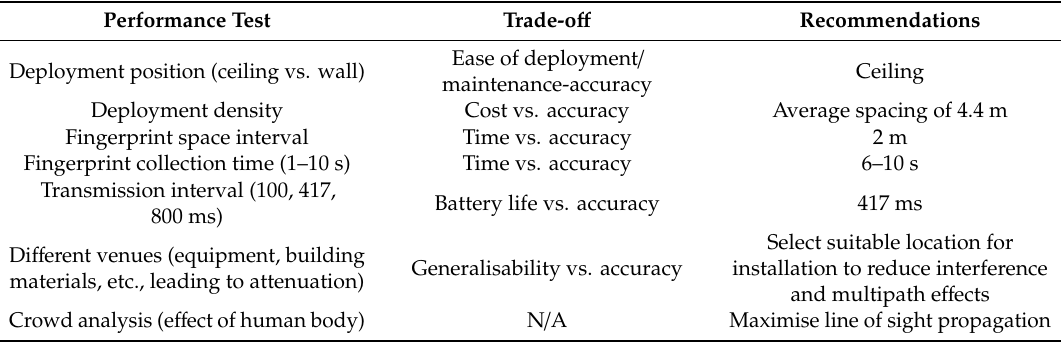
Table 4. Recommendations for iBeacon